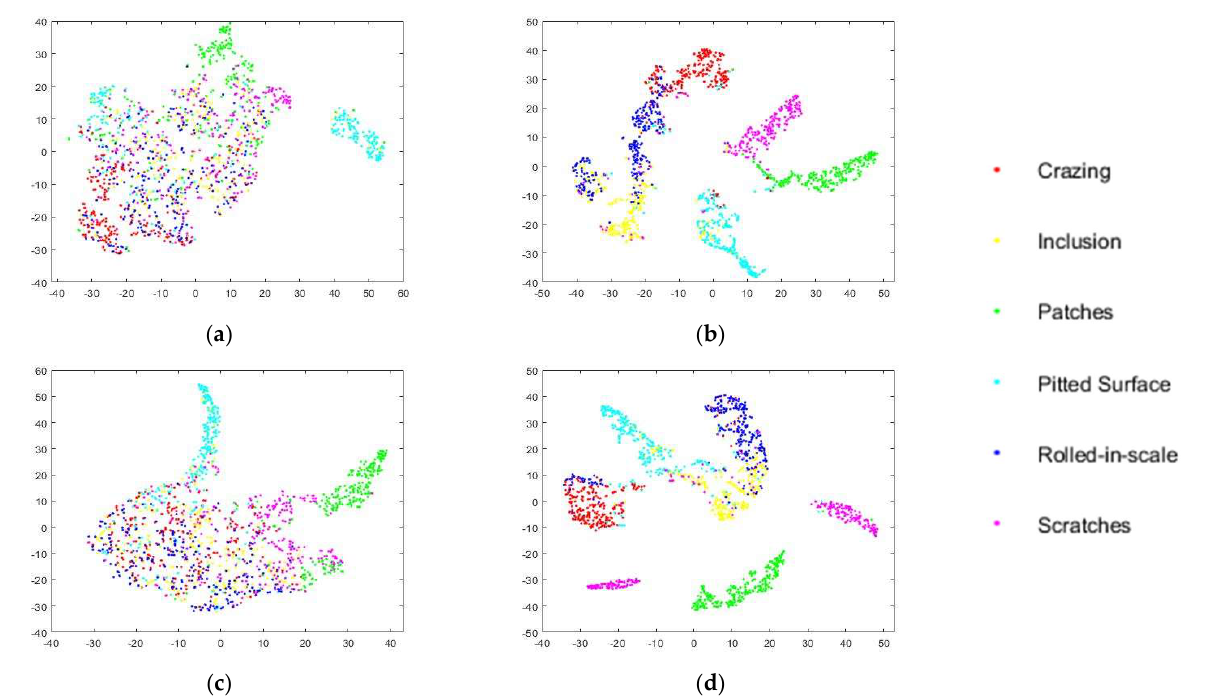
Figure 7. Feature visualization via t-SNE on Gaussian white noise (Variance 0.3). The feature vectors are extracted from the activations of the fully connected layer. ( a ) The original level 0 model. ( b ) The retrained level 0 model. ( c ) The original level 1 model. ( d ) The retrained level 1 model.